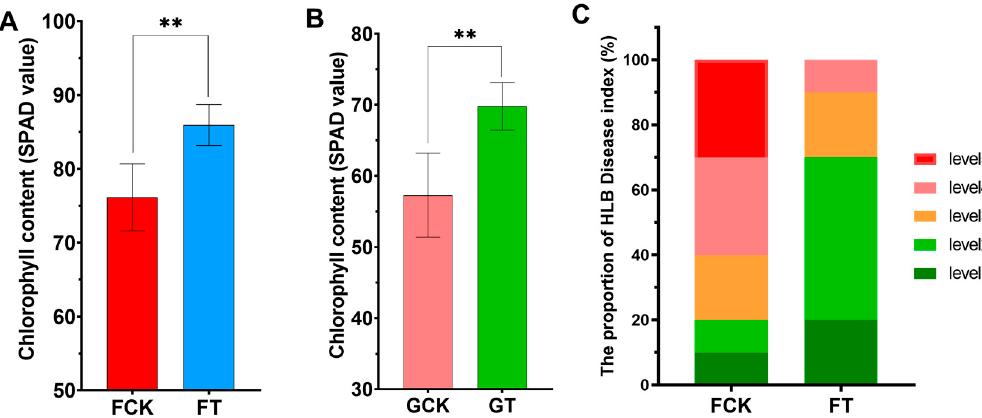
Figure 2. E ff ect of acid soil improvement on the content of chlorophyll in infected leaves and the progression of Huanglongbing (HLB) disease. The relative chlorophyll content (SPAD value) of HLB-infected citrus leaves at the fifth month after soil treatment in the field trial ( A ) and greenhouse trial ( B ). Data represent the mean ± SD of four independent biological replicates. ( C ) HLB disease index was assessed by measuring the proportion of limbs expressing HLB symptoms of each tree at the fifth month after soil treatment ( n = 20). FCK, control grove in field trial; FT, treatment grove in field trial. GCK, control group in greenhouse trial, GT, treatment group in greenhouse trial. Asterisks indicate a significant di ff erence according to the Student’s t -test: ** p < 0.01.